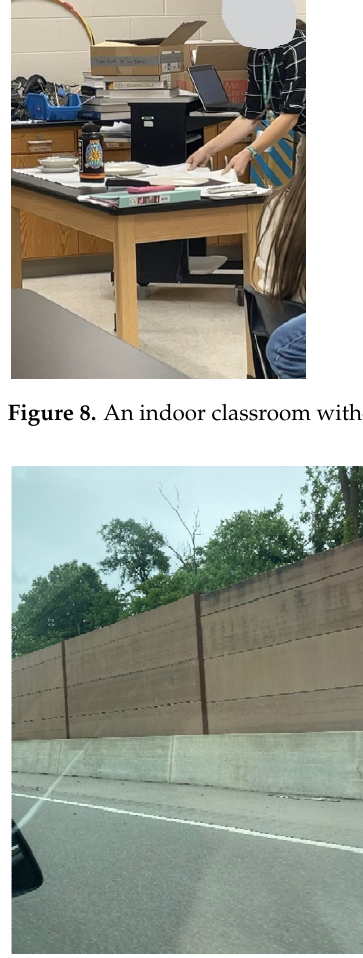
Figure 9. A highway view.